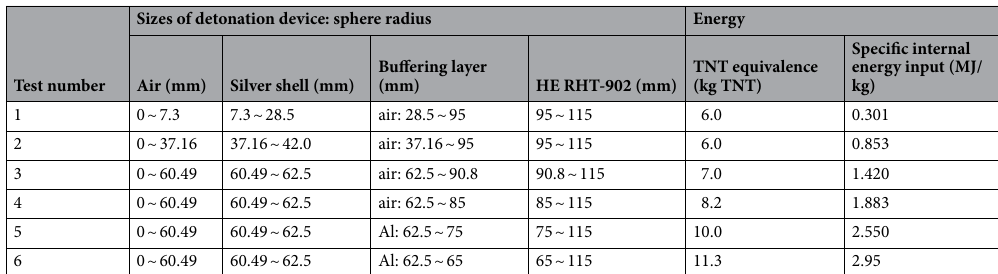
Table 2. Design of HE detonation devices. To simulate the lower order explosion in an accident, the loading strength of implosion was mitigated by applying a buffering layer of air or aluminum between silver and HE.